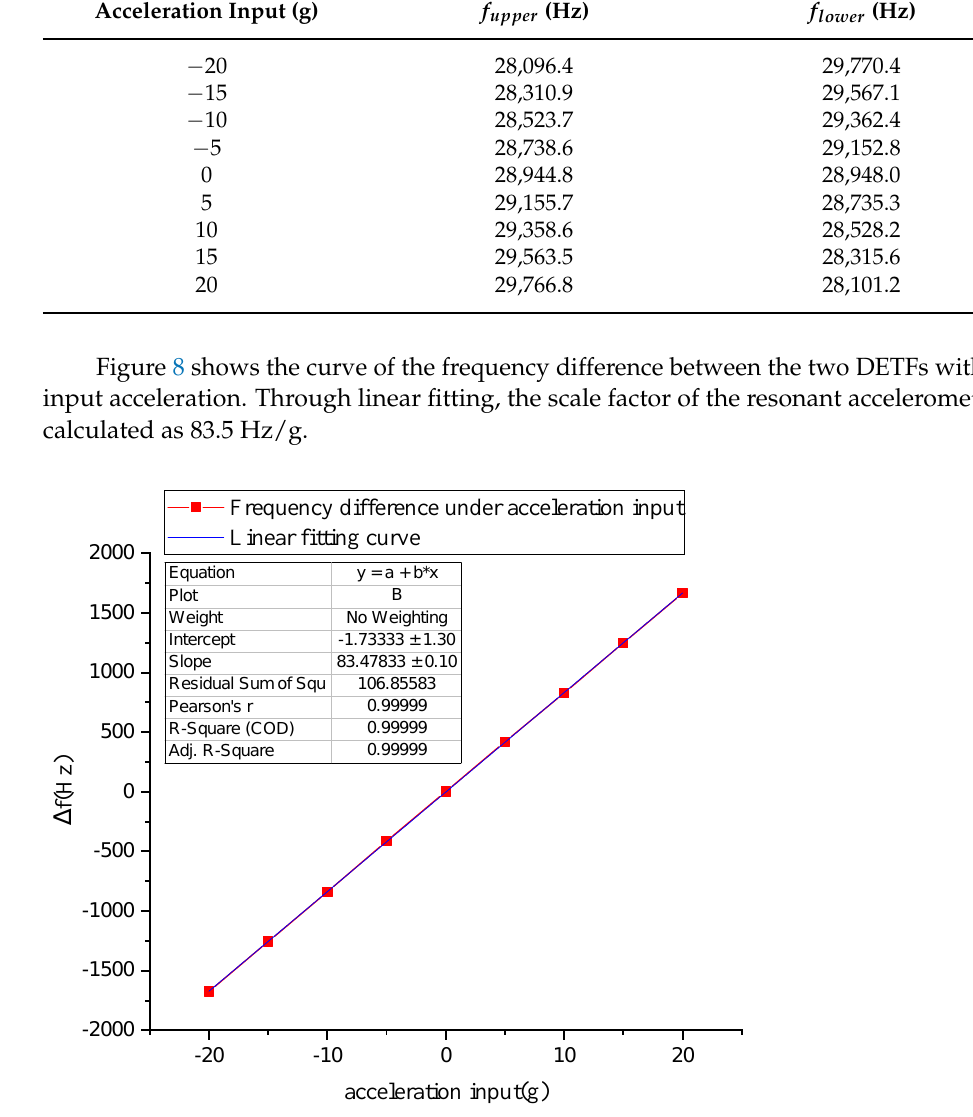
Figure 8. The scale factor of the resonant